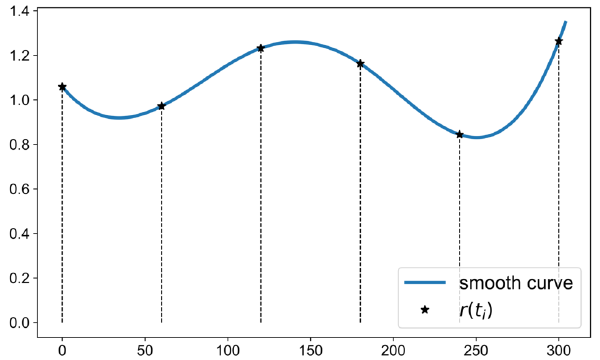
Figure A1. Example of smooth curve generation used in the MW method. Random values for T = 6 equidistant points are sampled from N ( µ = 1, σ = 0.2 ) and then interpolated using a cubic spline.